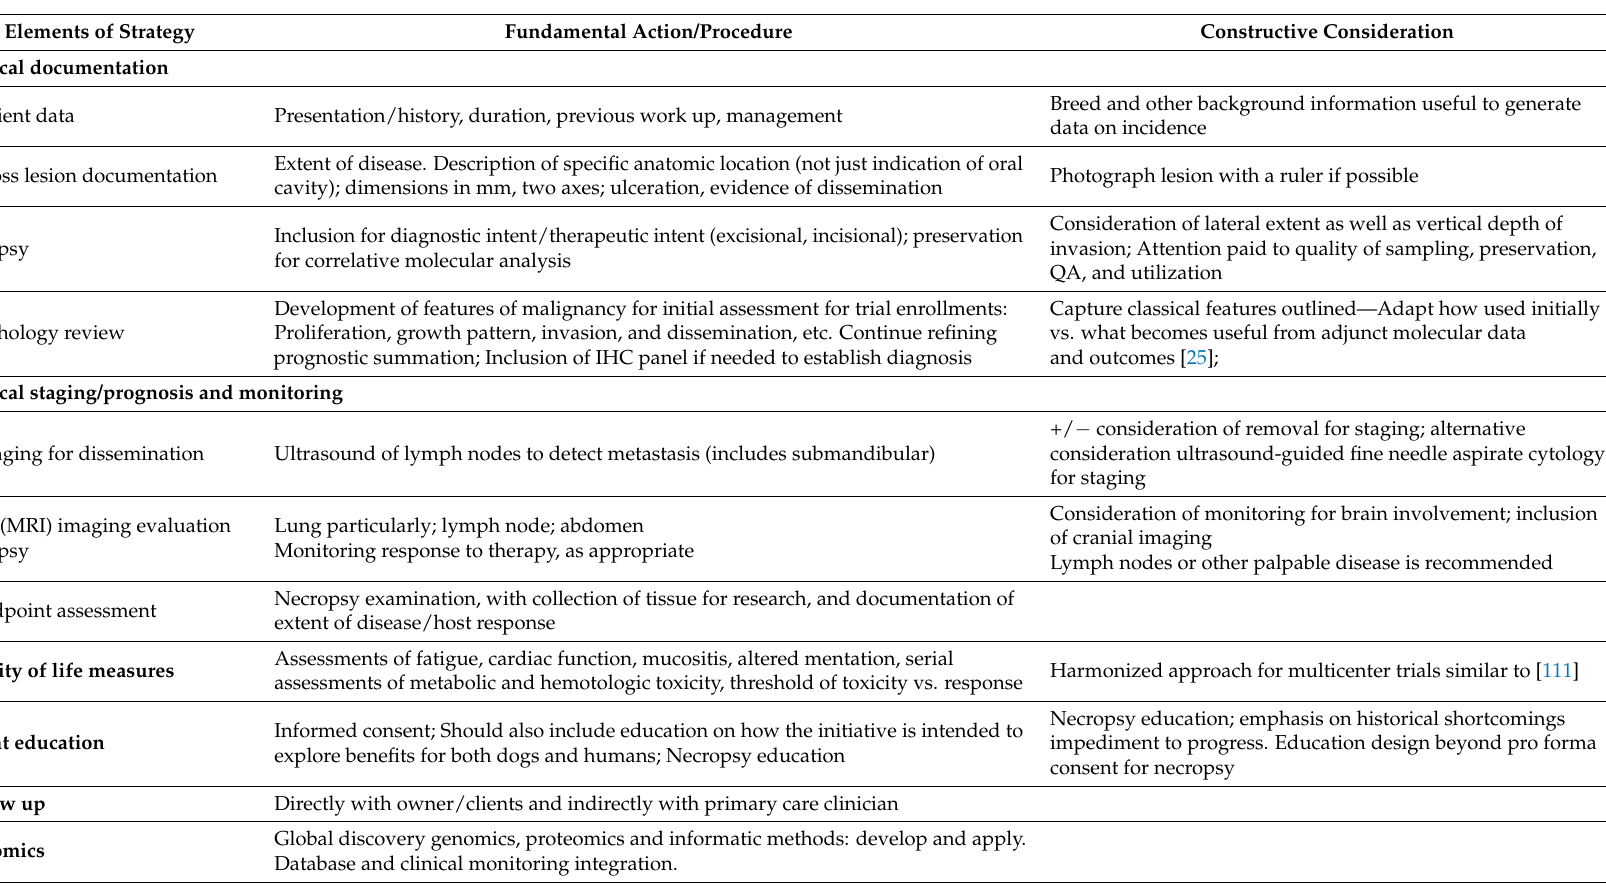
Table 2. Suggested consideration for canine melanoma surrogate-clinical trial development 1